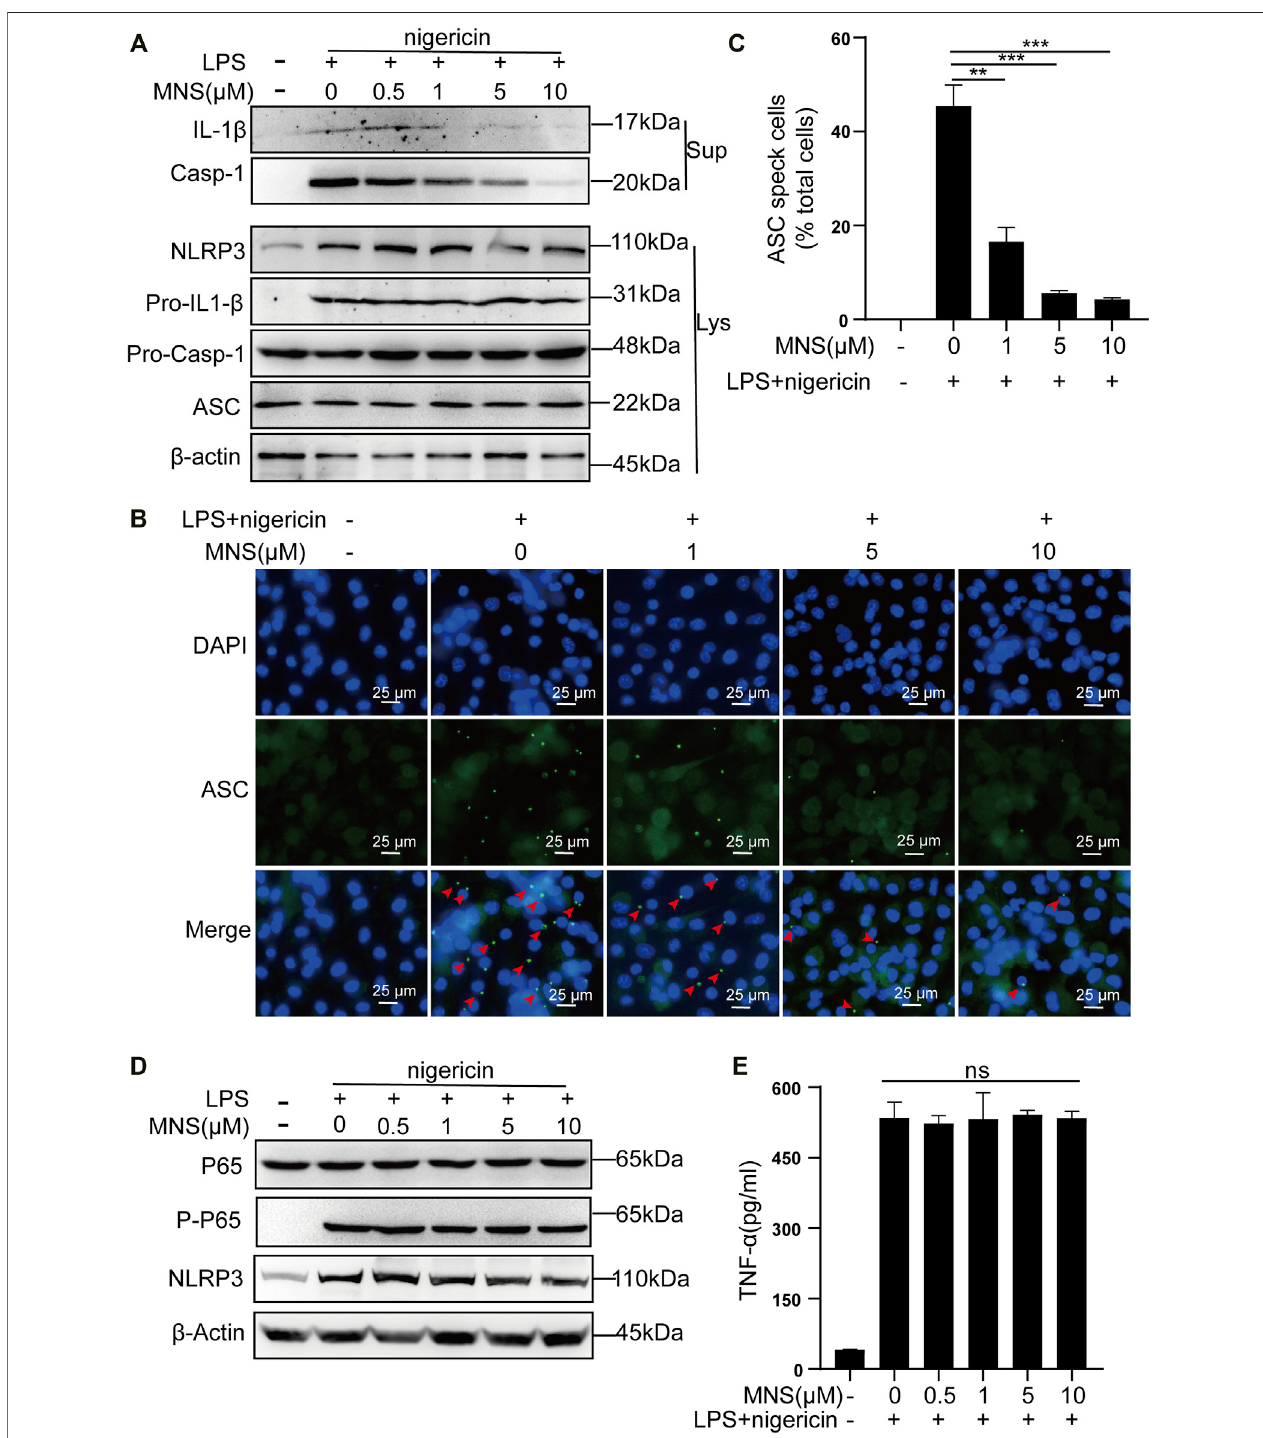
FIGURE 2 | MNS inhibited activation of the NLRP3 in fl ammasome in vitro. (A – E) LPS-primed BMDMs were treated with MNS (0.5 – 10 μ M) for 1 h, followed by 15 μ Mnigericinfor30 min.MatureIL-1 β andcaspase-1(Casp-1)weremeasuredinsupernatants(Sup);NLRP3,pro – IL-1 β ,pro – caspase-1(Pro – Casp-1),andASCwere measured in whole-cell lysates (Lys) by immunoblotting (A) . BMDMs were stained with anti – ASC antibodies for ASC specks (green) and DAPI for nuclei (blue). ASC specks were marked with red arrows (B) . BMDMs with ASC specks were represented as a percentage of total cells (C) . BMDM p65 and P-p65 levels were examinedbyWesternblotting. (D) TNF- α levelsinthesupernatantweredetermined byELISA (E) .Datawereexpressedasthemean±standarderrorofthemean(SEM) ( n = 3). Statistical analyses were performed using an unpaired two-tailed Student ’ s t-test; ns = not signi fi cant; * p < 0.05, ** p < 0.01, and *** p < 0.001 vs. without MNS treatment.